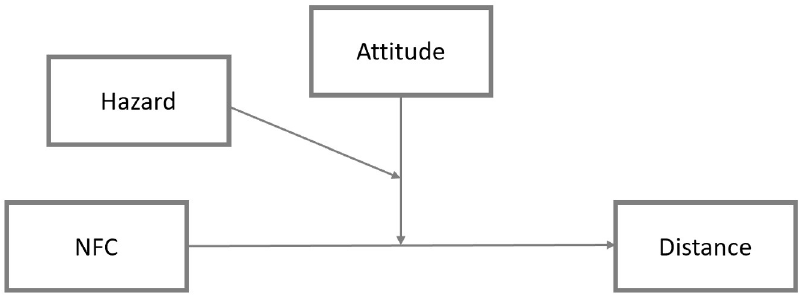
Fig 4. Conceptual model: Three-way interaction effect of attitude (W) and technology (Z) on the relationship between NFC (X) and distance between harms and benefits (Y).